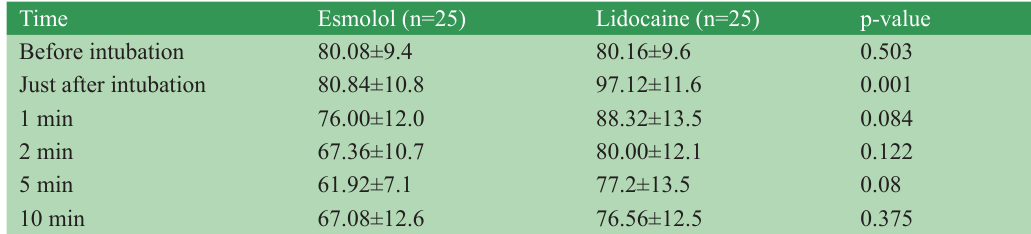
Table 7: Mean diastolic blood pressure (mmHg) between esmolol and lidocaine groups Time